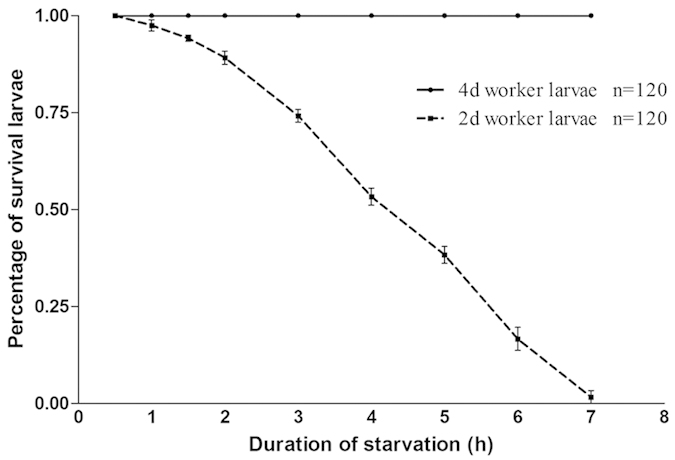
Survival of worker larvae with different durations of starvation from 0 to 7 hours.4-day old larvae (solid line and diamonds) survived longer than 2-day old larvae (dash line and squares). Forty 2- and 4-day old larvae were tested and the study was replicated three times. The mean + SE of each time point were presented.